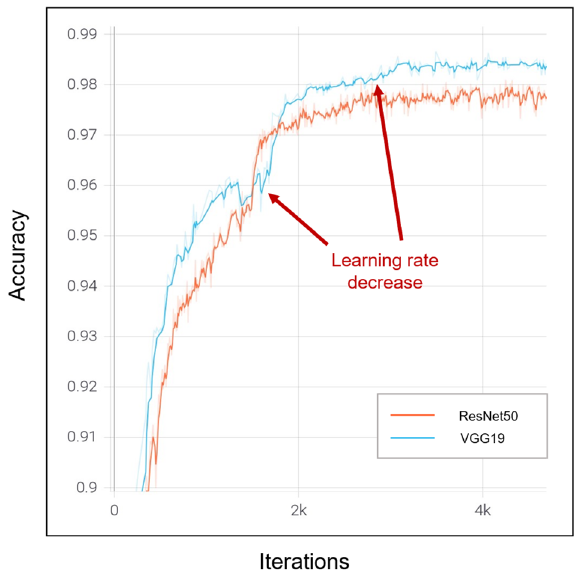
Figure 7. A scaled training accuracy plots of VGG19 and ResNet50 models. Sudden jumps highlighted with red arrows refer to the learning rate decrease.